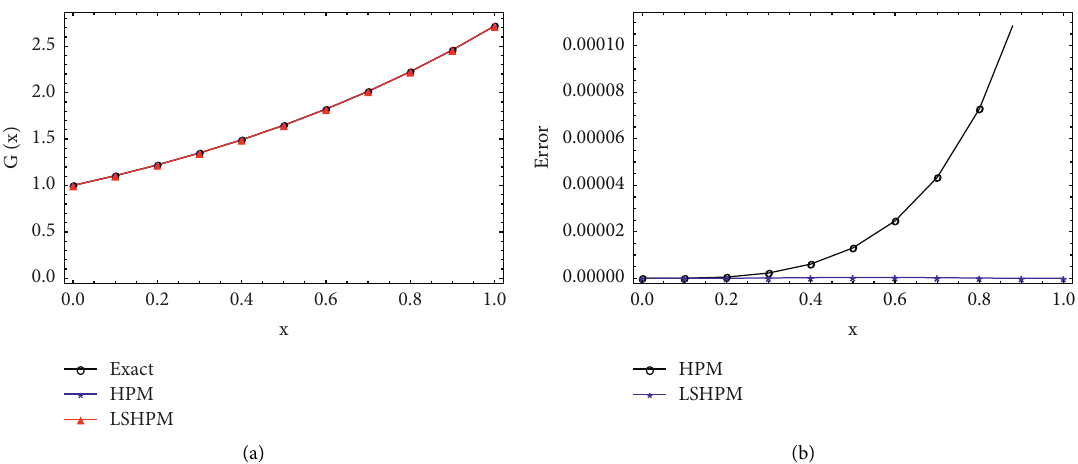
Figure 12: Graphical representation of solutions and errors in Problem 12. (a) Comparison of Exact, HPM, and LSHPM solutions. (b) Comparison of absolute errors of HPM and